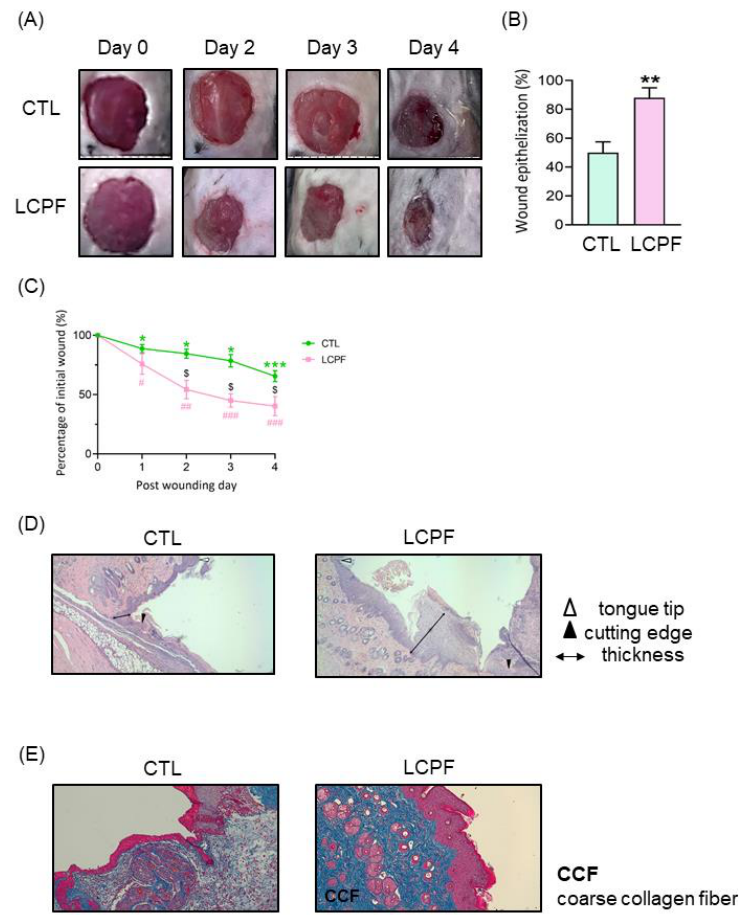
Figure 8. Accelerated wound closure via LCPF-based wet dressing in the mouse skin wound model with increased re-epithelization and collagen synthesis. Using a 6 mm biopsy punch, two full- thickness excision wounds were created on the dorsal skin of the mice. Following the operation, the LCPF-based wet dressing was immediately applied to the left dorsal wound and changed daily. Wet dressing with 0.9% saline served as a control on the right dorsal wound. ( A ) Representative photographs of wounds on different days after wounding. ( B ) The bar graph shows the comparison of epithelization area between the CTL- and LCPF-treated groups. ( C ) The graph shows the time-course changes in the relative percentage of initial wound area between the CTL- and LCPF-treated groups. ( D ) Histological sections of wounds treated with topical 0.9% saline and LCPF at day 4 post-operation (tongue tip; cutting edge; thickness). ( E ) Collagen deposition between wound wet dressing with 0.9% saline and LCPF at day 4 post-operation using Mason trichome staining. (CCF, coarse collagen fiber.) * p < 0.05; ** p < 0.01; *** p <0.005ompared to the initial wound area of the CTL group. # p < 0.05; ## p < 0.01; #### p < 0.0001 compared to the LCPF group. $ p < 0.05 compared to the change in wound area percentage of the CTL group.